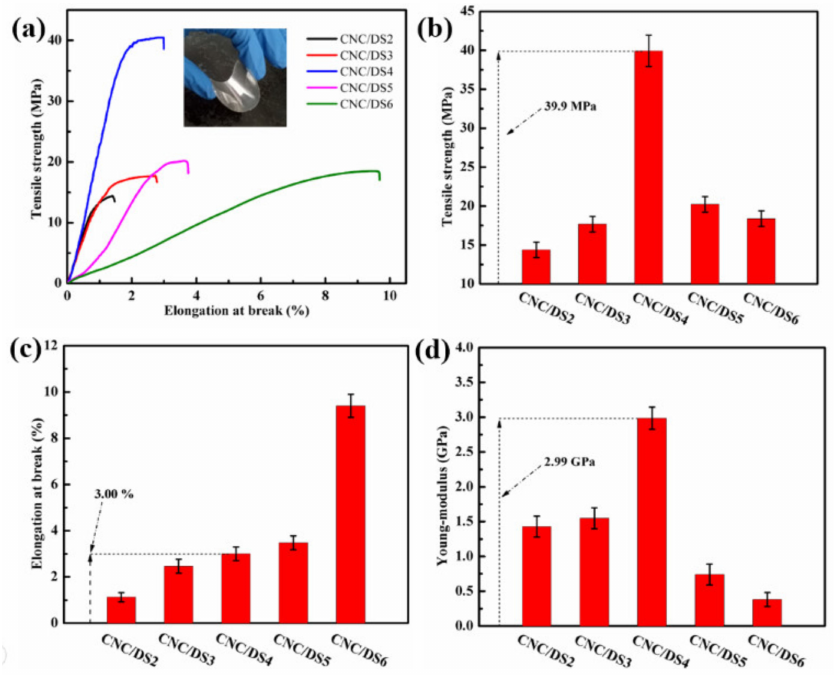
Figure 5. Typical ( a ) stress–strain curves and bended CNC/DS4 film, ( b ) tensile strength, ( c ) elonga- tion at break, and ( d ) Young modulus of CNC/DS films.